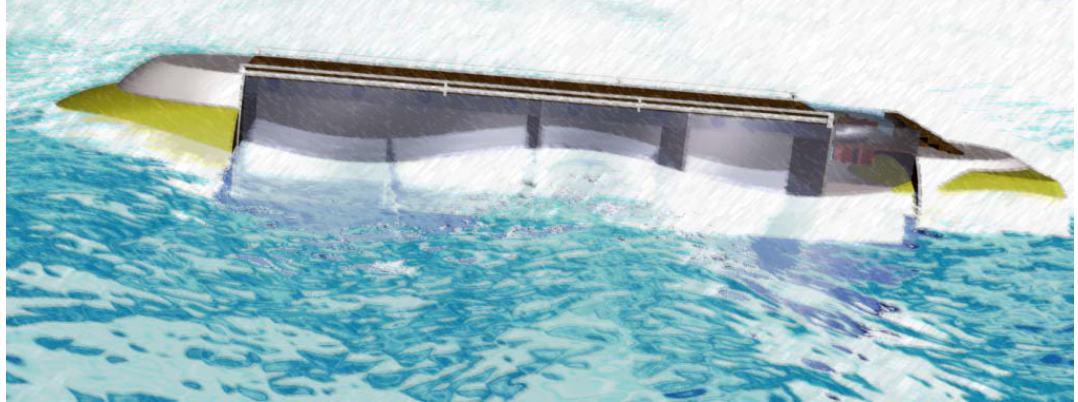
Figure 6. The Seabreath concept: behaviour in the sea